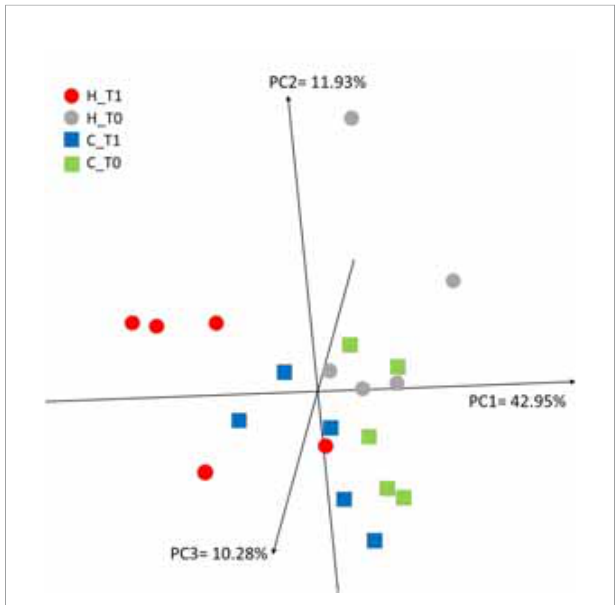
FIGURE 1 | Principal component analysis describing the 13,063 mRNAs expressed in milk somatic cells (MSCs) from the fi ve goats fed with the control (C, square) diet and fi ve goats fed with the hemp seed (H, circle) diet at the two time points (T0 and